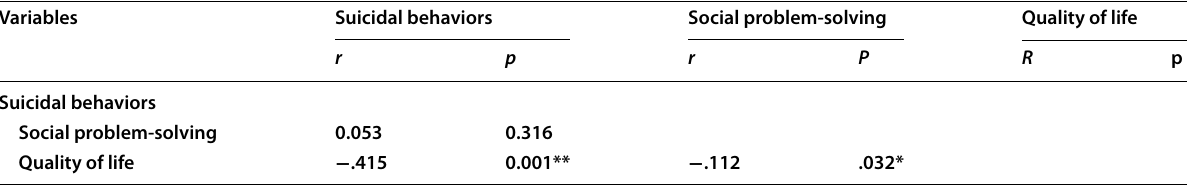
Table 5 Correlation matrix between study variables ( n